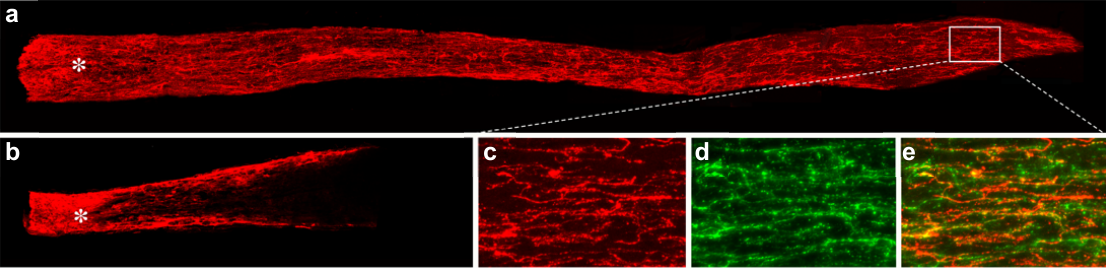
Figure 7. Full-length optic nerve regeneration. ( a ) Intraocular inflammation combined with CPT- cAMP and virally mediated PTEN deletion enables RGCs to regenerate axons the full length of the optic nerve in 8–10 weeks. Axons are labeled by intraocular injection of cholera toxin B fragment (CTB, red). ( b ) Control optic nerve in case treated with intraocular Zymosan and a control virus. ( c – e ) Enlargements of area within rectangle show overlap in immunostaining fibers for CTB ( c , red) and the growth-associated protein GAP43 ( d , green). Asterisks show lesion site [79]. SOCS3 (Suppressor of cytokine signaling) represses Jak-STAT signaling, the trans-